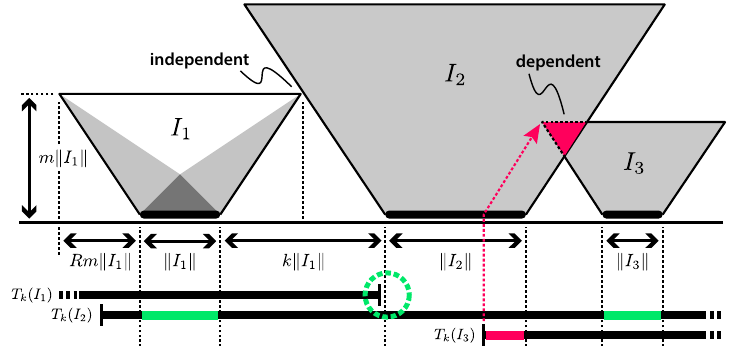
Figure 6: Independent clusters. A pattern of three clusters I (cid:107) I (cid:107) < (cid:107) I (cid:107) < (cid:107) I (cid:107) . The erosion process of TLV is sketched for I 3 1 2 the causal patches that cover the erosion are shaded gray (time runs upwards). For a linear eroder, the erasure of an independent cluster requires at most m (cid:107) I the shown trapezoids. During this time, signals can travel at most Rm (cid:107) I ary of a cluster I . Clusters that are independent with sparseness parameter k = 2 Rm do not i ∩ T ( I ) = (cid:59) (dashed circle). Note that I interact; this is true for I and I since I k 1 2 2 1 (green intervals) has no effect on their (in-)dependence because (cid:107) I ∩ T ( I ) (cid:54) = (cid:59) (red interval), the causal trapezoids of I since I k 2 3 Thus, I and I are dependent and may not be erased 2 3